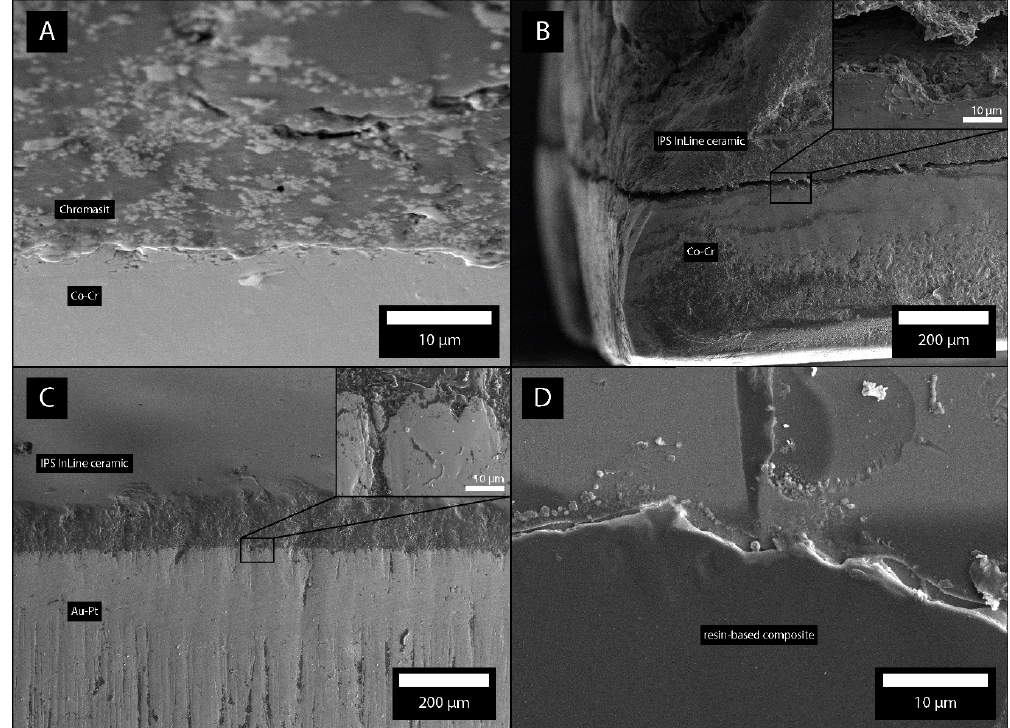
Figure 9. Plates composed of Chromasit and Co-Cr ( A ), ceramics and Co-Cr ( B ), ceramics and Au-Pt ( C ), and composite ( D ). The gaps between the materials with adhered bacteria are shown by SEM. The insets show the regions of pronounced bacterial adhesion.